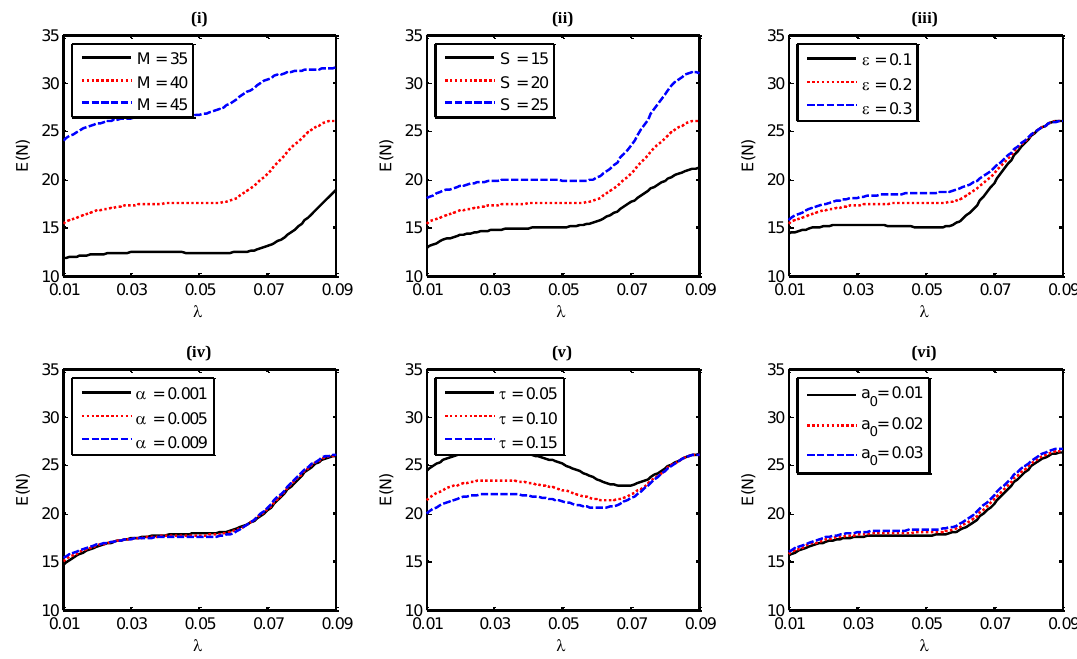
Figure 2. The expected number of failed machines in the system ( ) NE wrt failure rate of the operating machines ( ) 